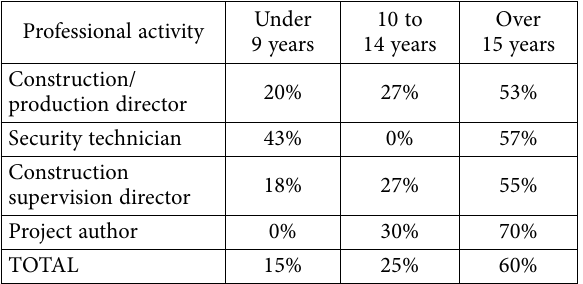
Table 4. Distribution of respondents’ experience in CDW management according to their professional activity ( n = 153)